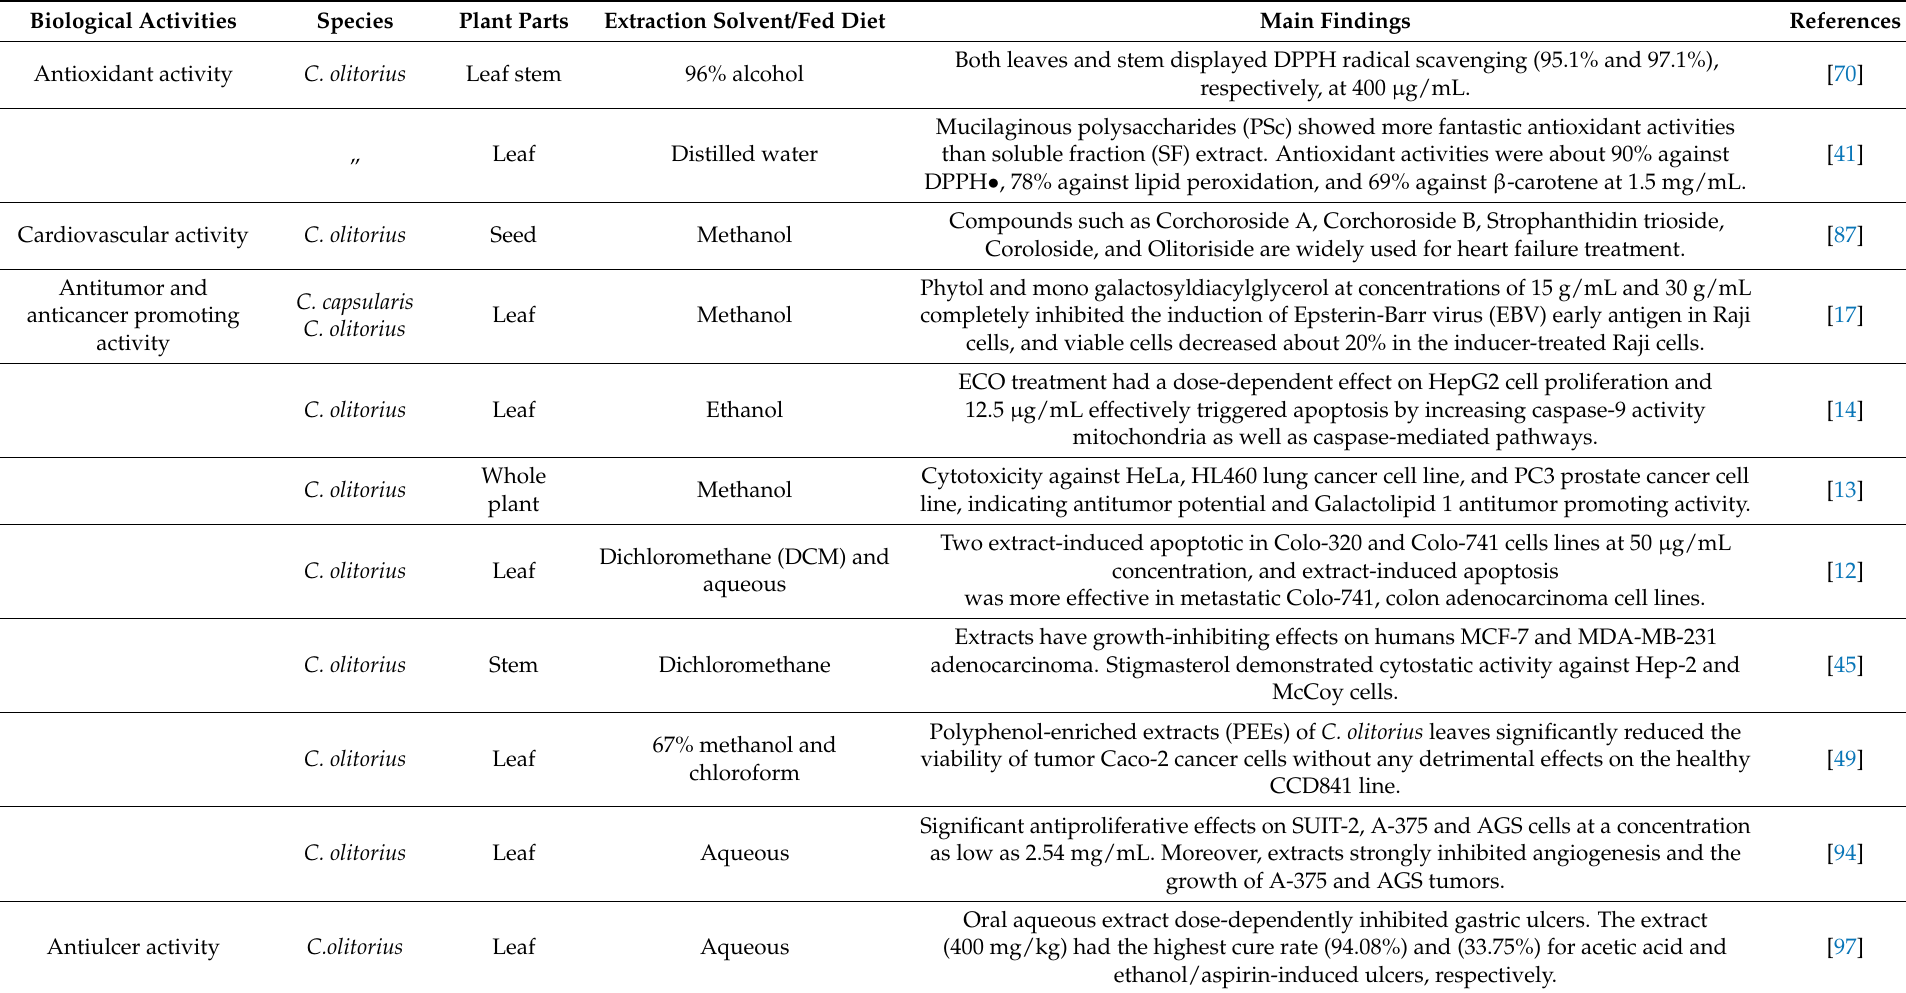
Table 4. A summary of the biological activities of C. capsularis and C. olitorius